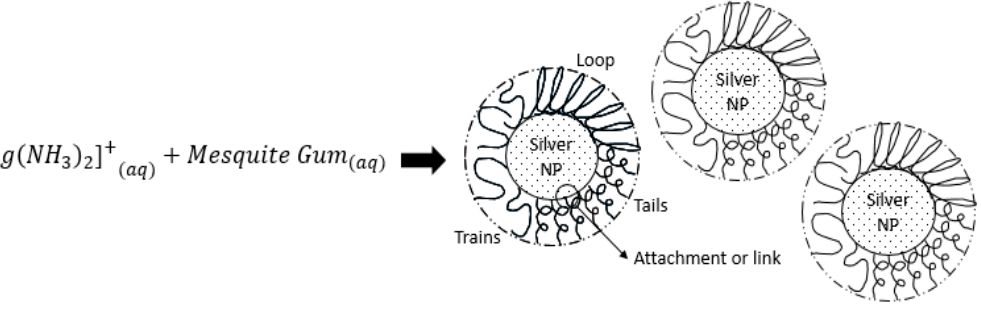
Figure 5. Schematic diagram of steric stability conferred to silver nanoparticles by the mesquite gum.